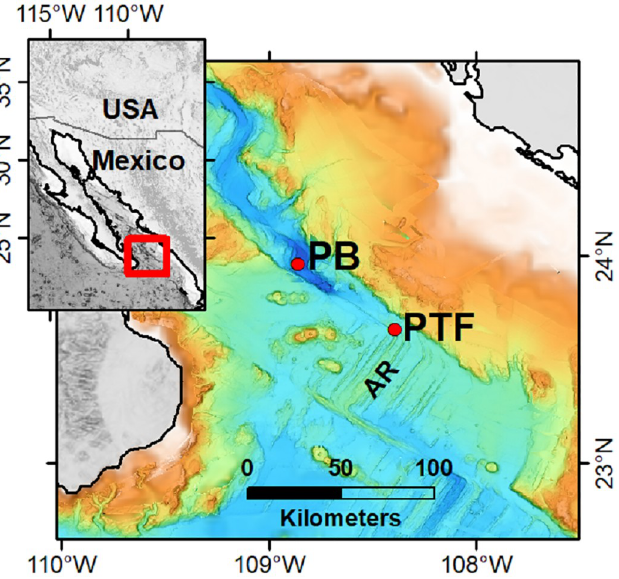
Fig 1. Location of the study area in the southern Gulf of California, Mexico. Vent sites are red dots. PB = Pescadero Basin. PTF = Pescadero Transform Fault.